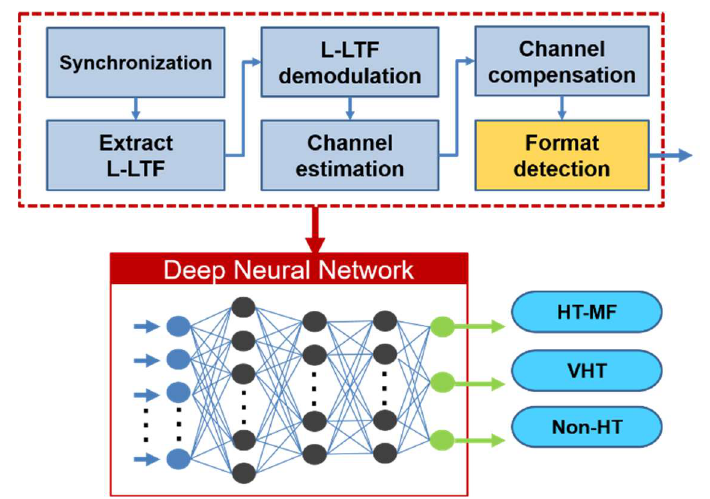
Figure 4. Block diagram of the proposed deep-learning-based frame format detection method.